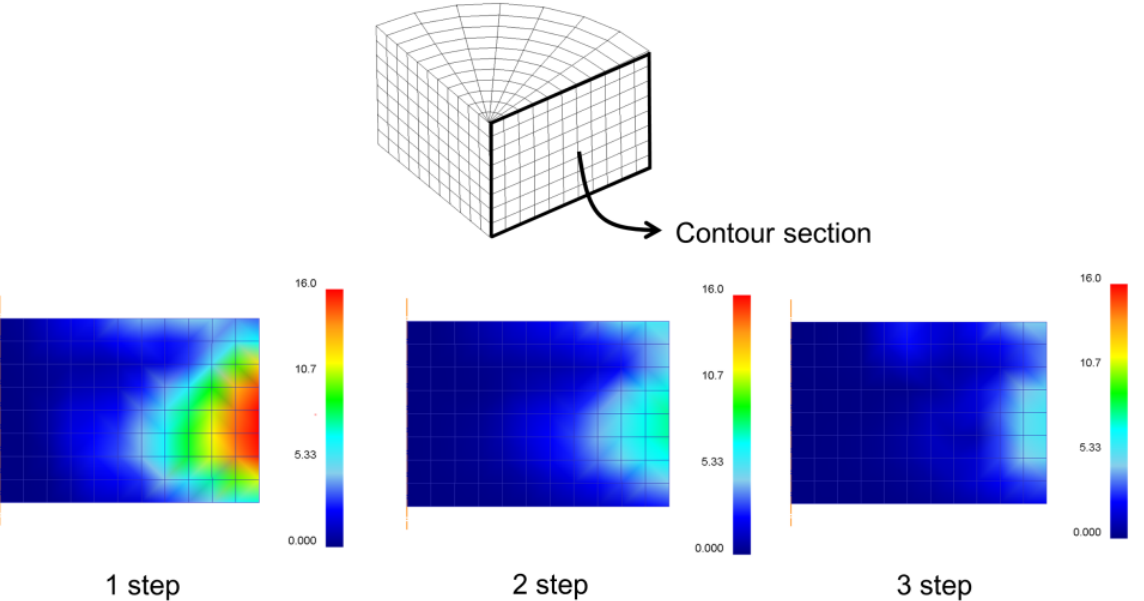
Figure 8. Section contour of residual stress in step cure process.